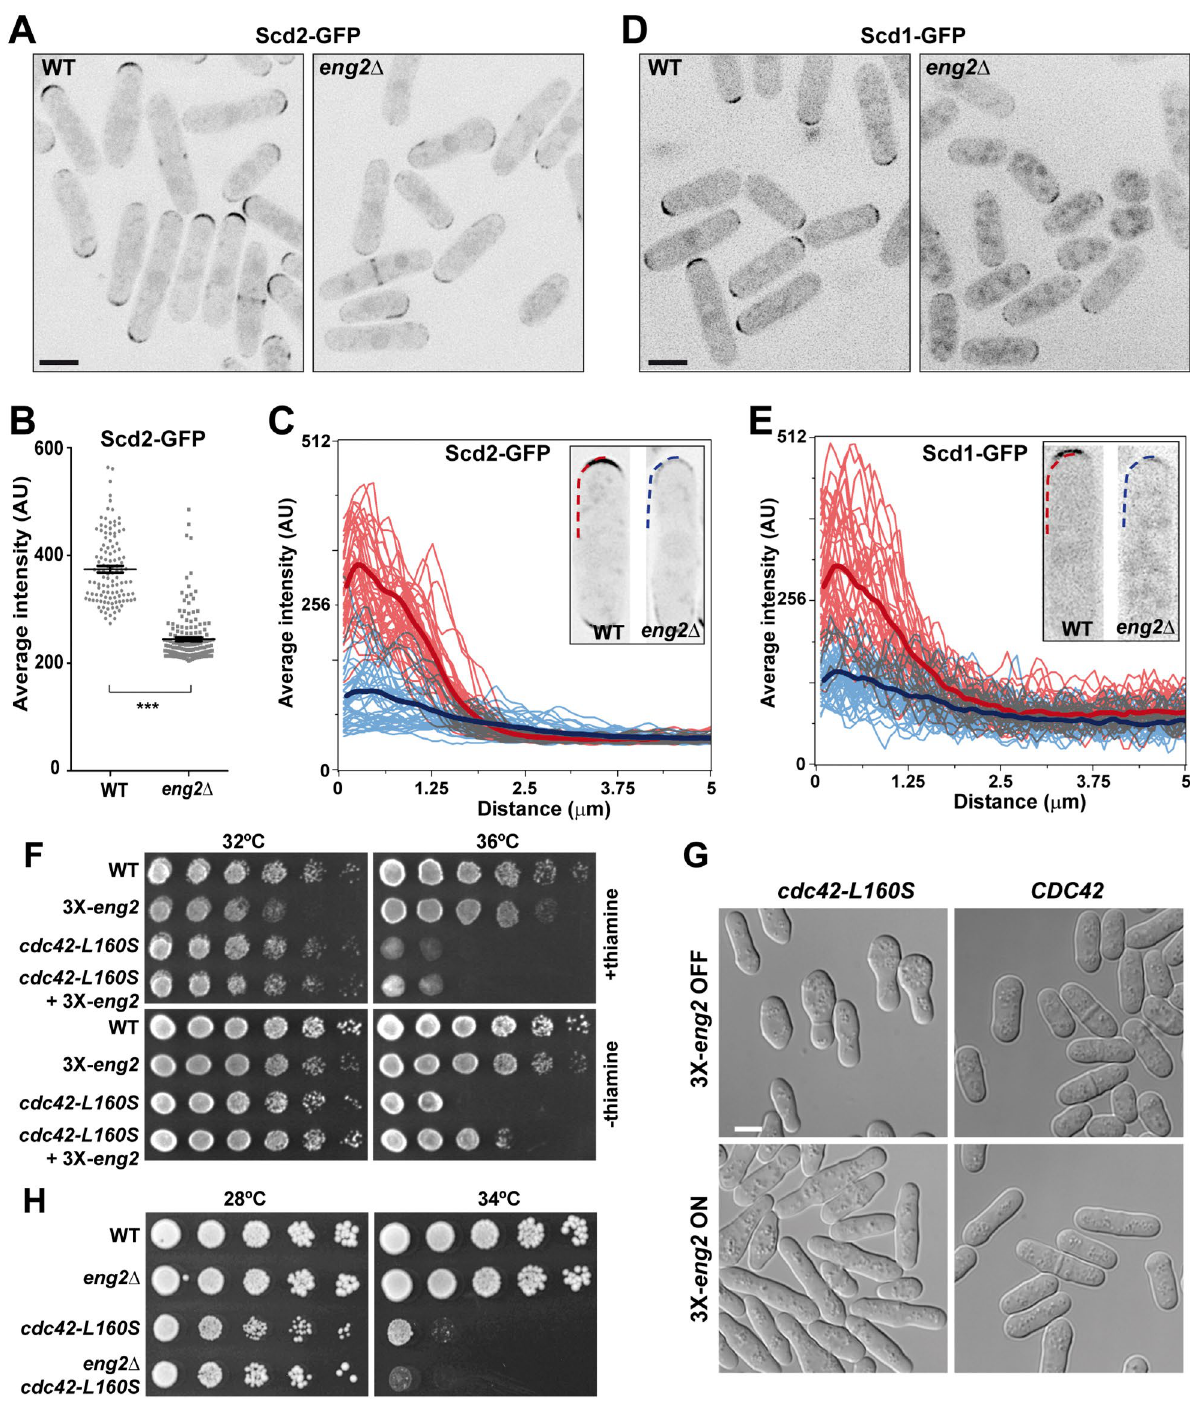
Figure 5. Eng2 governs the intracellular distribution of Scd1 and Scd2. (A) Localization of Scd2-GFP in wild-type and eng2 Δ cells grown in EMM medium at 32 °C. Images show the maximum intensity projection of 5 focal planes acquired at 0.3-µm intervals. Scale bar, 5 μm. (B) Average ± s.e.m. intensity of Scd2-GFP at the tips in each strain (n > 150 from 3 independent experiments; ***p-value < 0.0001). (C) Plots of the Scd2-GFP fluorescence intensity along the membrane in wild-type (red) and eng2 Δ cells (blue). The thick line is the average of line scans from > 40 cell tips. The image and graph show a representative example of the majority of wild-type cells and eng2 Δ cells. Linescans were done on half tips, aligned by the cell center, as shown by the curved line in the image. (D) Localization of Scd1-GFP in cells grown in YES medium at 25 °C. Images show the maximum intensity projection of 5 focal planes acquired at 0.3-µm intervals. Scale bar, 5 μm. (E) Plots of the Scd1-GFP fluorescence intensity along the membrane in wild-type (red) and eng2 Δ cells (blue) as in (C) . (F) Serially diluted growth spots of the wild-type (WT) and the cdc42-L160S either carrying Pnmt1-eng2 + (3X-eng2) thiamine repressible version or not, grown in EMM medium in the presence (+ thiamine) or absence (-thiamine) of thiamine at the indicated temperatures. (G) DIC micrographs showing the morphology of CDC42 and cdc42-L160S cells overexpressing eng2 + (3X-eng2 ON) from the Pnmt1 promoter or not (3X-eng2 OFF). Scale bar, 5 μm. (H) Serially diluted growth spots of the wild-type, eng2 Δ, cdc42-L160S and eng2 Δ cdc42-L160S mutants at the indicated temperatures in YES